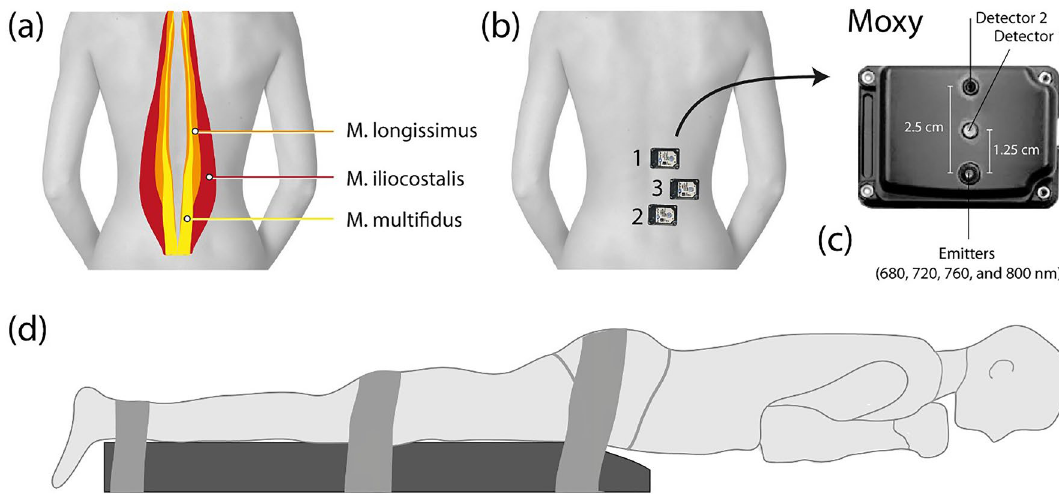
Figure 1. Positioning of the test subject and NIRS oximetry devices during the Biering–Sorensen muscle endurance (BSME) test. ( b ) Schematic representation of the location of M. longissimus , M. iliocostalis and M. multifidus , ( c ) positioning of the NIRS oximetry devices in the back, ( d ) close-up of the NIRS oximeter. ( d ) Visualization of a test subject performing the BSME